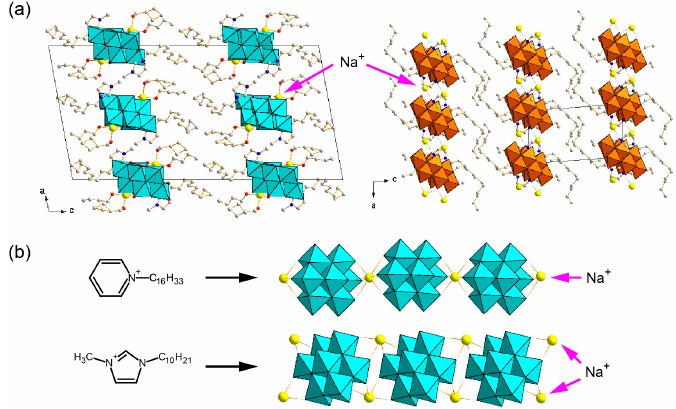
Figure 11. Proton-containing POM-surfactant crystals (left: crystal packing, right: molecular arrangement in the inorganic layer). ( a ) C 16 py- β -Mo 8 [122]; ( b ) C 10 NC 3 -V 10 [126]. Reproduced with permission from Mikurube, K. et al. , J. Chem.; published by Hindawi Publishing Corporation, 2013 and from Ito, T. et al. , Bull. Chem. Soc. Jpn. ; published by The Chemical Society of Japan, 2012.